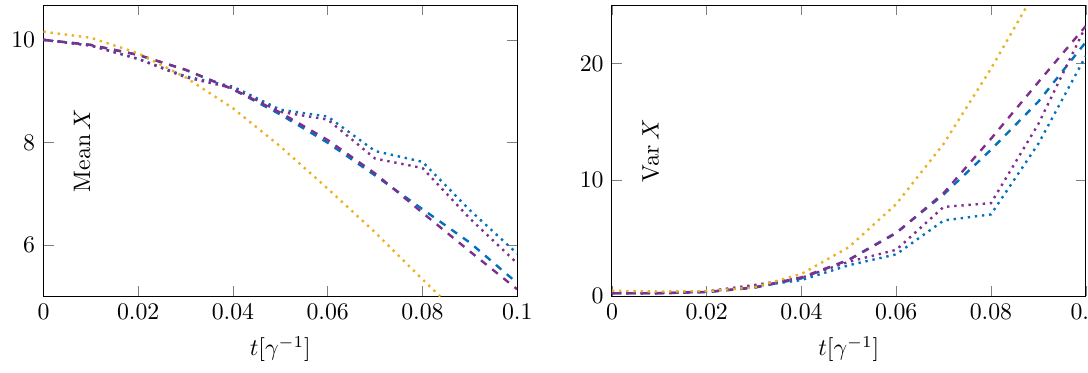
Figure 5. Same process as Figure 4 (corresponding legend) simulated with ten samples of exact/variational trajectories, as well as TWA. It is clear that trajectory methods are more tolerant for low statistics than TWA. Corresponding to the criterion (29), we see that photon-counting is still more tolerant than heterodyne detection, corresponding to the fact that Var 1 ( X ) photon-counting unraveling, as opposed to heterodyne. Note that the initial state already has a deviation from the true value for TWA, but not for the trajectory methods: the criterion (29) for the needed ratio of samples diverges